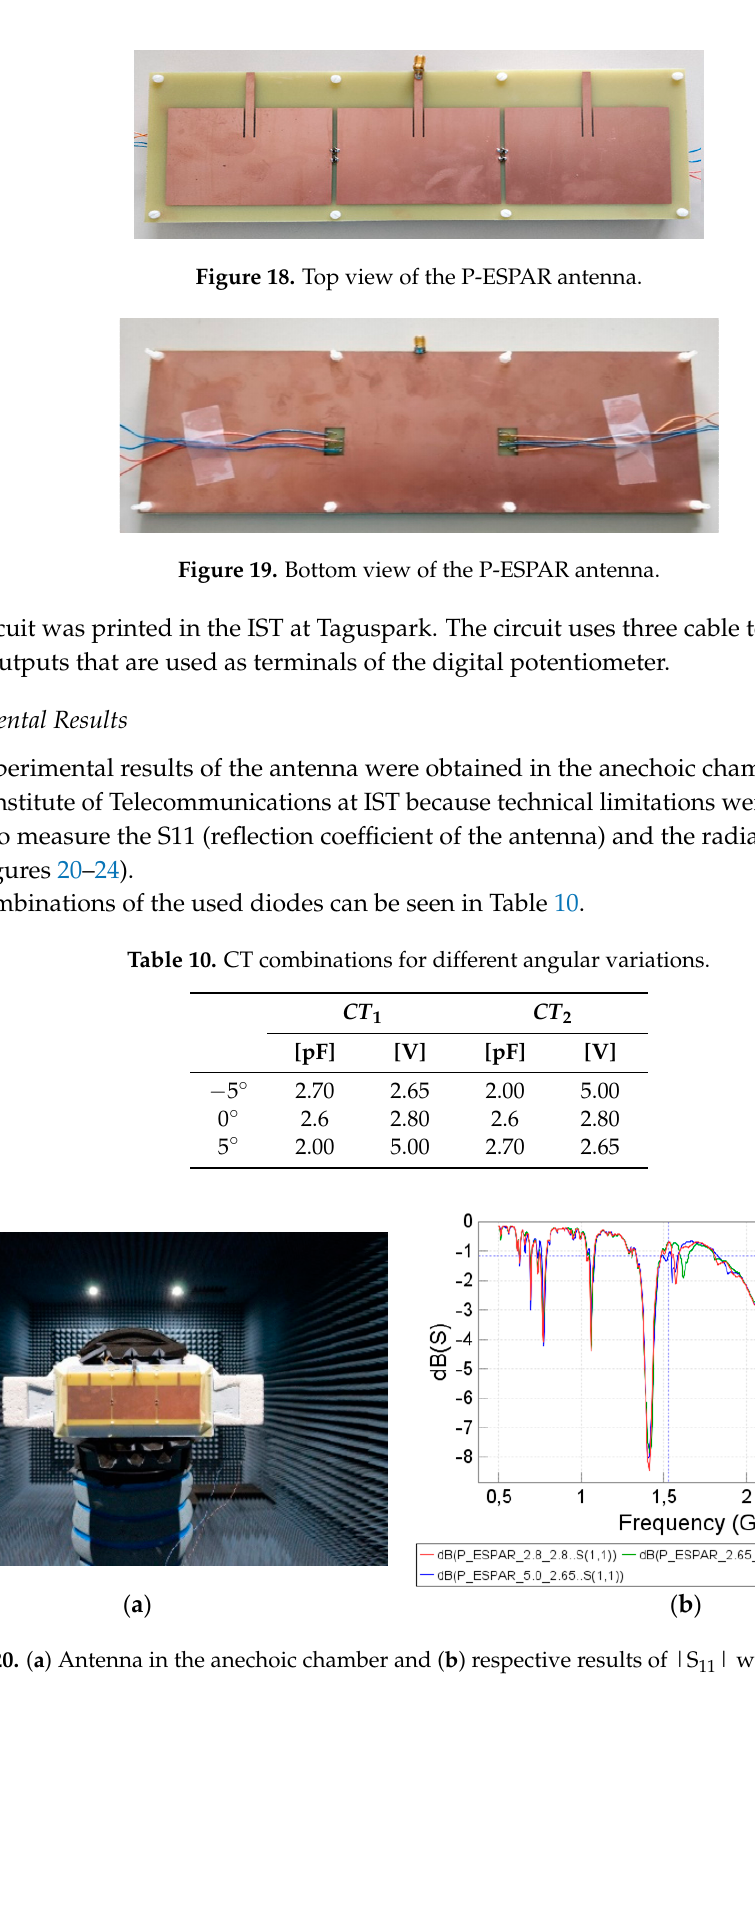
-60-40 Figure 21. Representation of the radiation diagram for 0° in the H plane. Figure 22. Comparison of the radiation diagram to ± 5° in the H plane. -80